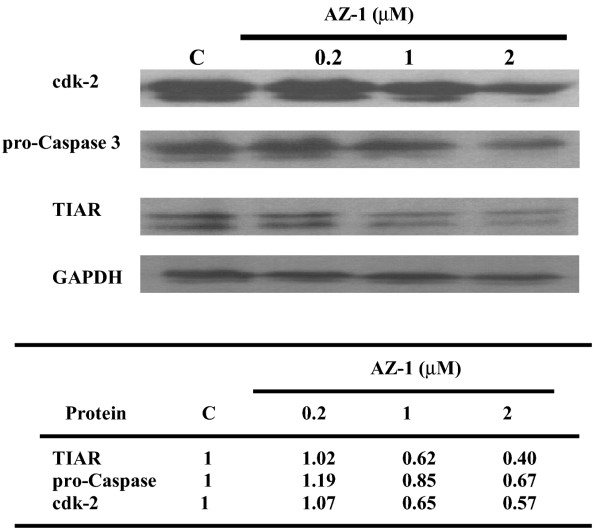
Bis-aziridinylnapthoquinone (AZ-1) alters the expression of apoptotic proteins. The protein expression of T-cell restricted intracellular antigen-related protein (TIAR), pro-caspase 3 and cyclin-dependent kinase (cdk2) were assessed by immunoblot. The BC-M1 cells were treated with various concentration of AZ-1 (lanes 2–4: 0.2 μM, 1.0 μM, and 2.0 μM) for 24 hours and cell lysate was prepared for analysis. Lane 1, untreated control (C). GADPH was an interna l control on BC-M1 cells.